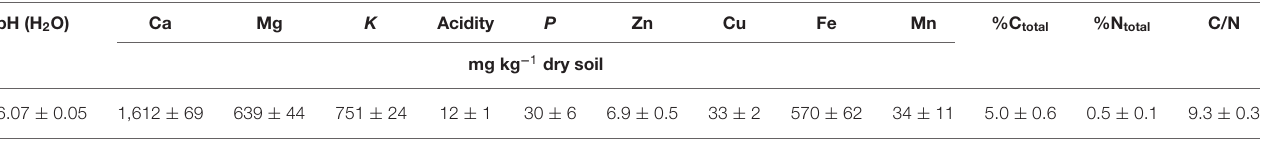
TABLE 2 | Chemical properties of a composite sample from the top soil layer (0–20cm) from the experimental area at the Alfredo Volio Mata Experimental Station (July 2017). pH (H 2 O) Ca Mg K Acidity P Zn Cu Fe Mn %C total %N total C/N mg kg − 1 dry soil 6.07 ± 0.05 1,612 ± 69 639 ± 44 751 ± 24 30 ±